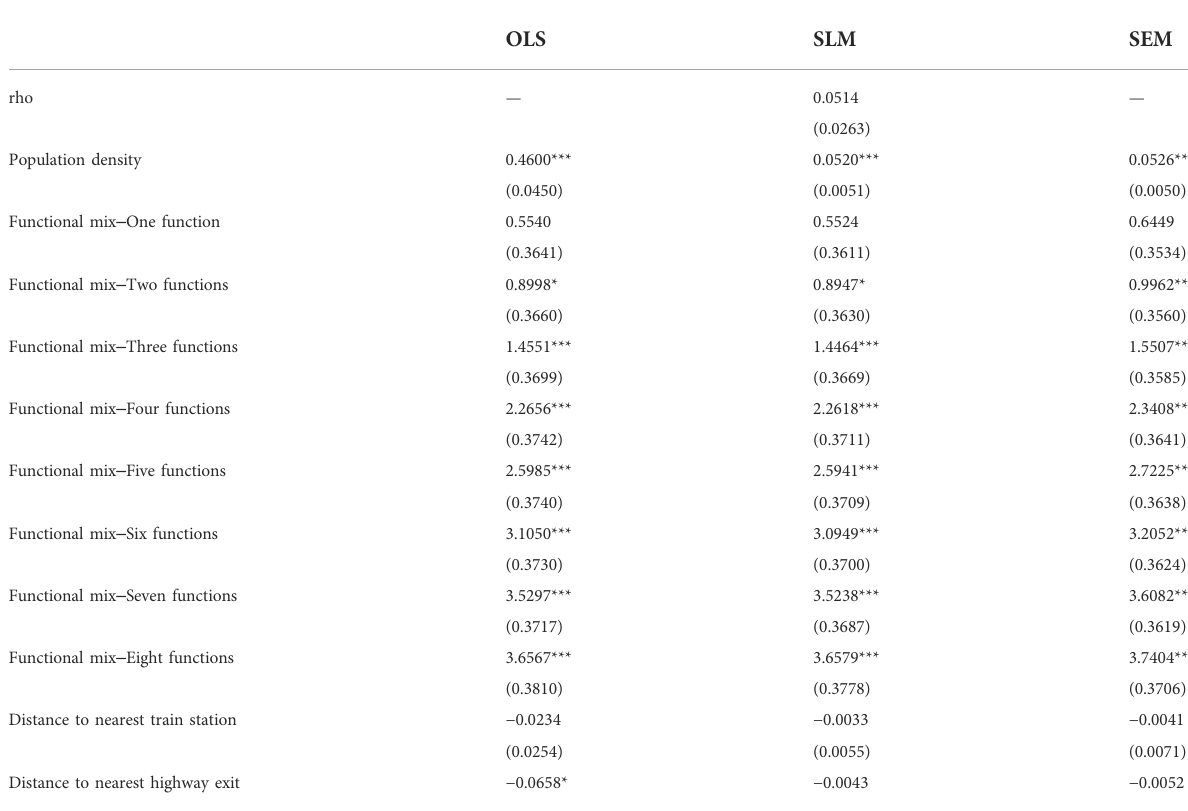
TABLE 2 Ordinary least squares and spatial model results (n =